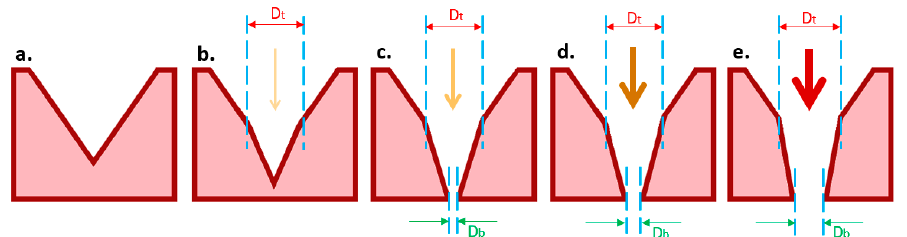
Figure 7. Schematic cross-sectional view of pyramidal-shaped micropores consisting of a combined pyramidal and conical shape to form a 3D micropore. D t represents the diameter of the through-hole top opening made by the laser ablation step in the process, where D b represents the bottom diameter; ( a ) an intact microcavity prior to ablation; ( b ) a low number of pulses may not make a through-hole at all or ( c ) may make a through-hole with a D b that is too small, which is not sufficient for cell capturing; ( d ) for an optimal number of laser pulses, the achieved D b is around 3 to 4 µm; ( e ) a higher number of pulses would widen the size D b , which may ultimately result in a poor capturing rate.